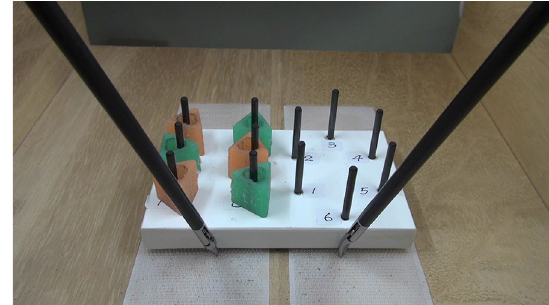
Figure 2. FLS psychomotor task, Peg transfer.